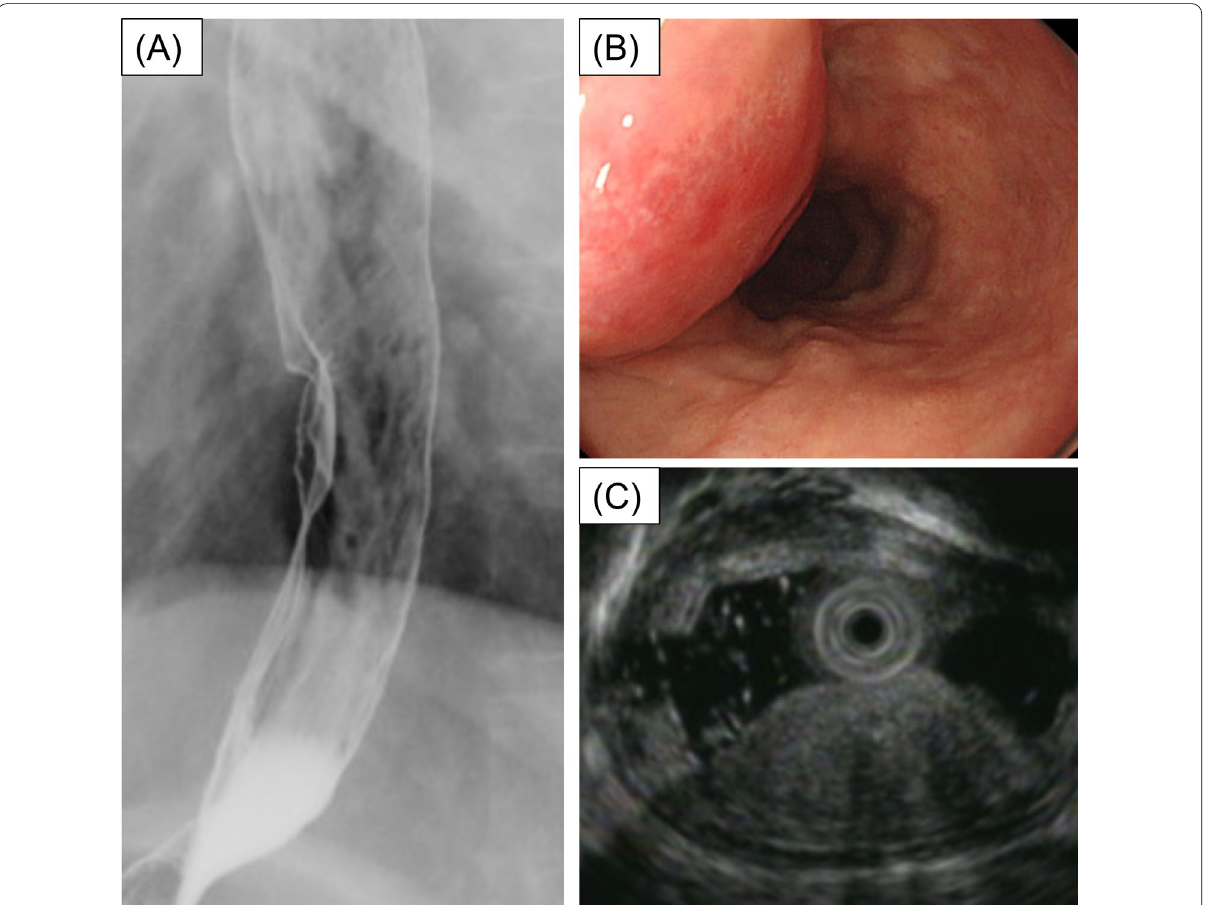
Fig. 1 Esophagogram test showed a dome-shaped tumor in lower thoracic esophagus ( A ). Endoscopy showed a round lesion with smooth surface and central redness ( B ). EUS showed a hypoechoic tumor in the second layer ( C